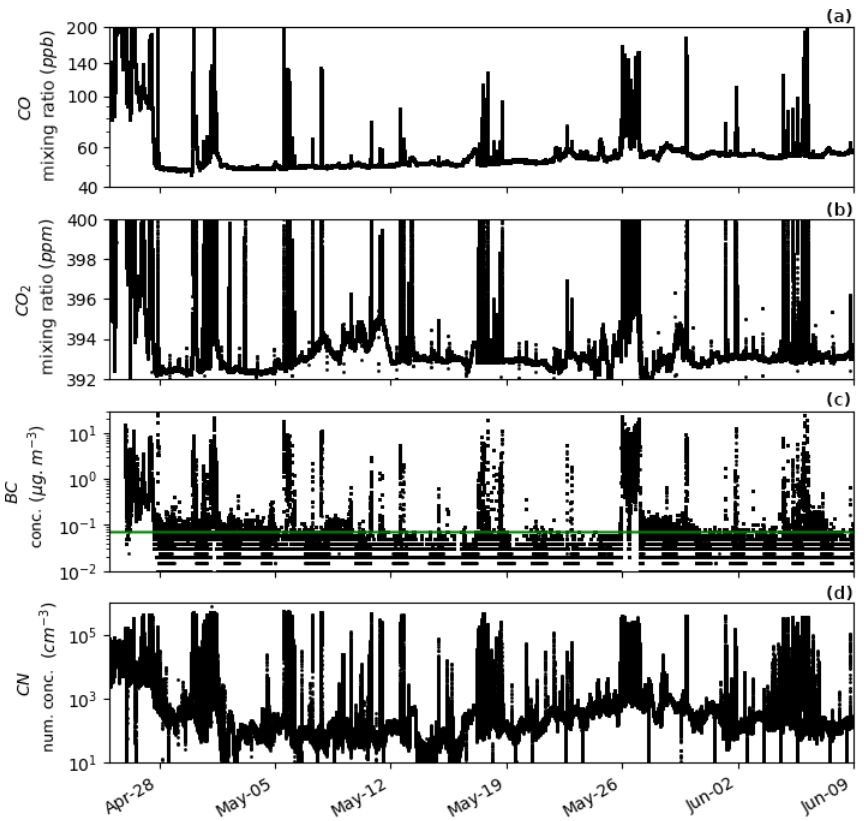
Figure A2. Time series (log scale) of CO, CO 2 , BC and CN for 45d of voyage IN2016_V03, which traversed from the ice edge to the Equator along the 170 ◦ W meridian with a short personnel exchange port period in Wellington, New Zealand, on 26 May 2016. The green line in panel (c) represents the BC limit of 0.07µgm − 3 utilised. This dataset was utilised for the algorithm development as it exhibits influences from urban and background marine regions, by which differentiation from ship exhaust must be